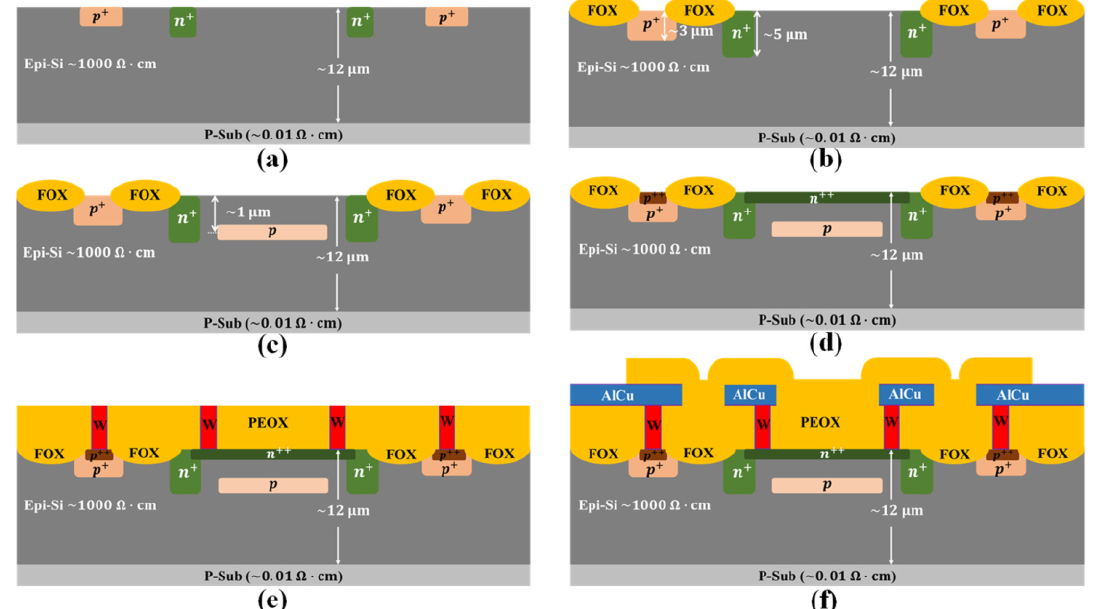
Figure 2. Key fabrication process of the Si APD: ( a ) implantation of P-well and N-well; ( b ) LOCOS and drive-in for P-well and N-well; ( c ) implantation for charge layer and annealing; ( d ) implantation for Ohm-contacts and rapid thermal annealing; ( e ) ILD0 deposition, CMP and tungsten-plugs formation; ( f ) AlCu deposition, patterning, and